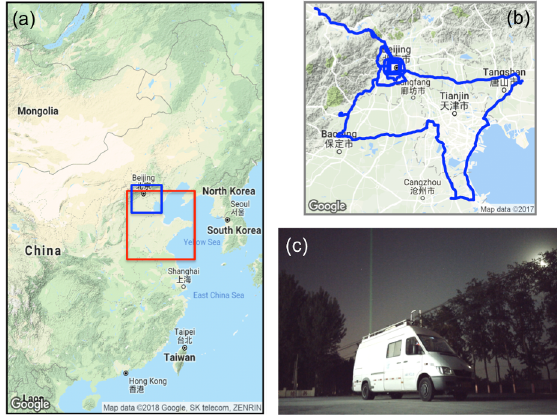
Figure 1. (a) North China Plain (red rectangle) and area investigated through mobile measurements (blue rectangle), (b) GPS track of all mobile transects during MOABAI and (c) IAP/LAGEO instrumented van used for mobile